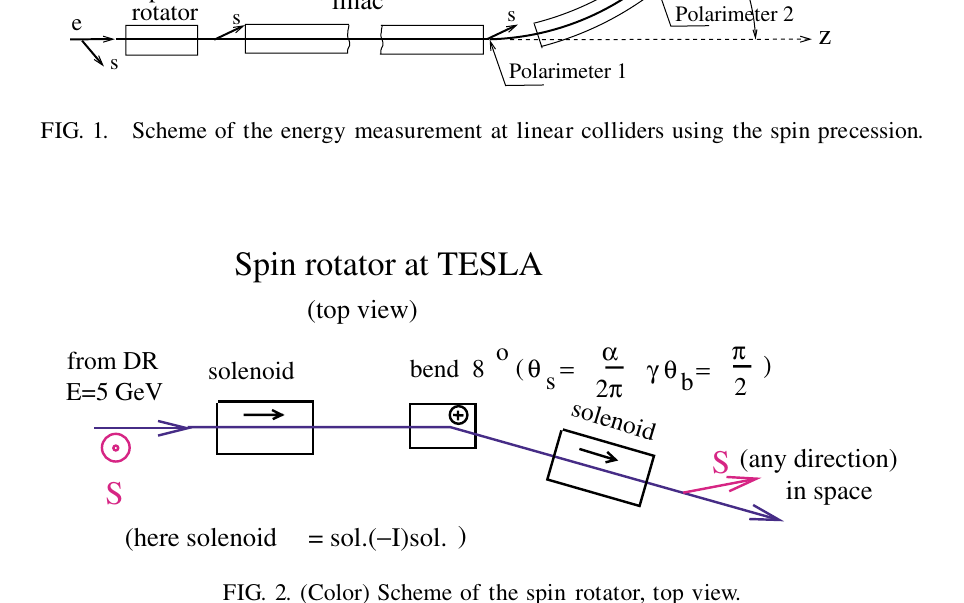
FIG. 2. (Color) Scheme of the spin rotator, top view.